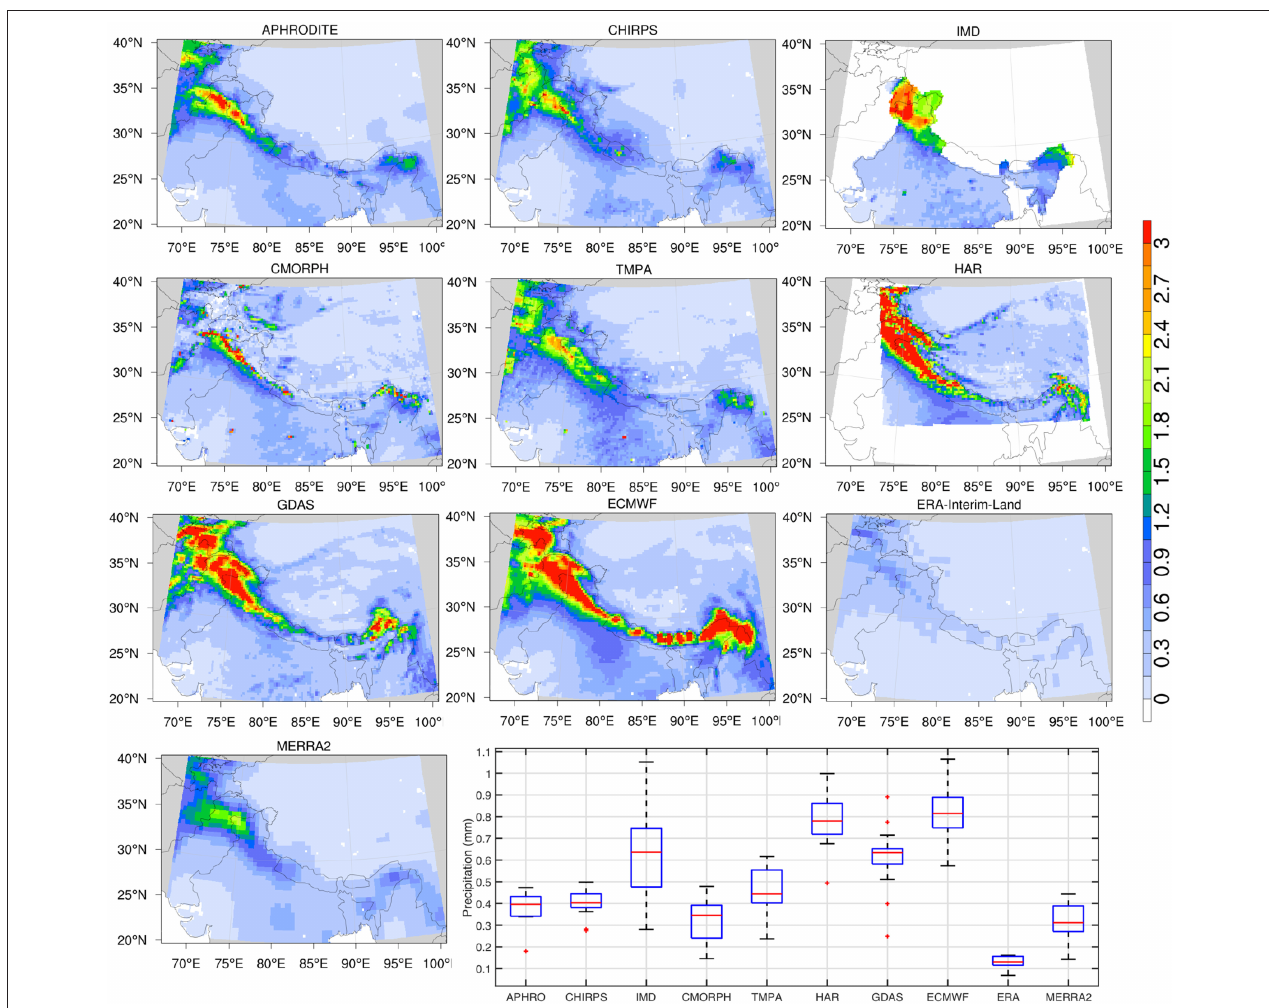
Figure 8 shows the domain-averaged mean annual precipitation from these datasets along with estimates of their temporal trends for the four sub-regions of HMA ( Figure 1 ). Note that for some datasets (IMD and HAR), the spatial averages are influenced by their limited spatial